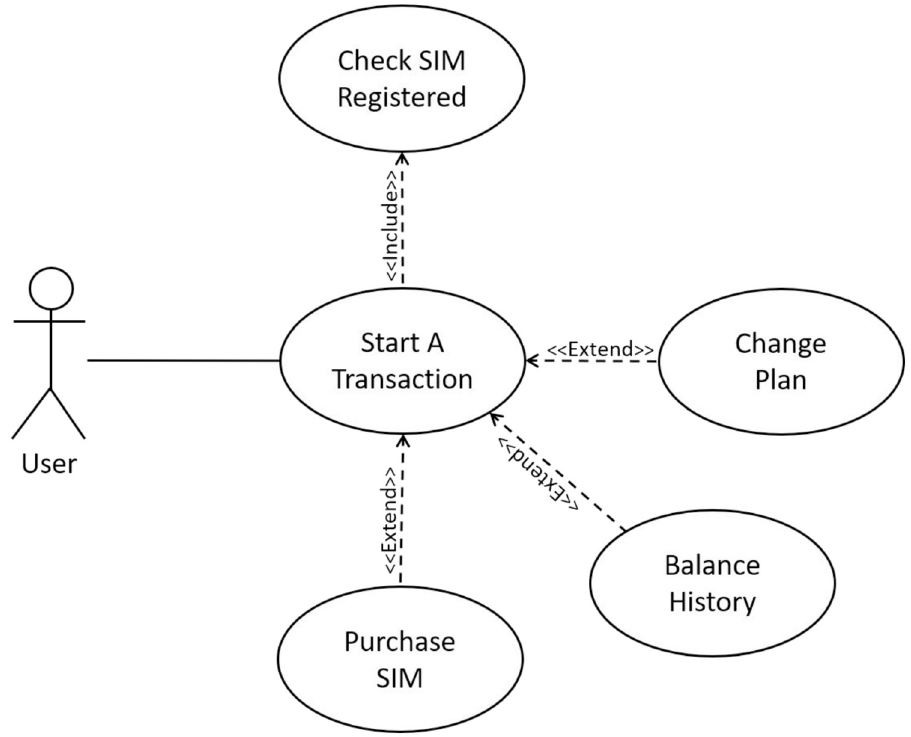
Fig 9. A SIM vending machine start a transaction use case